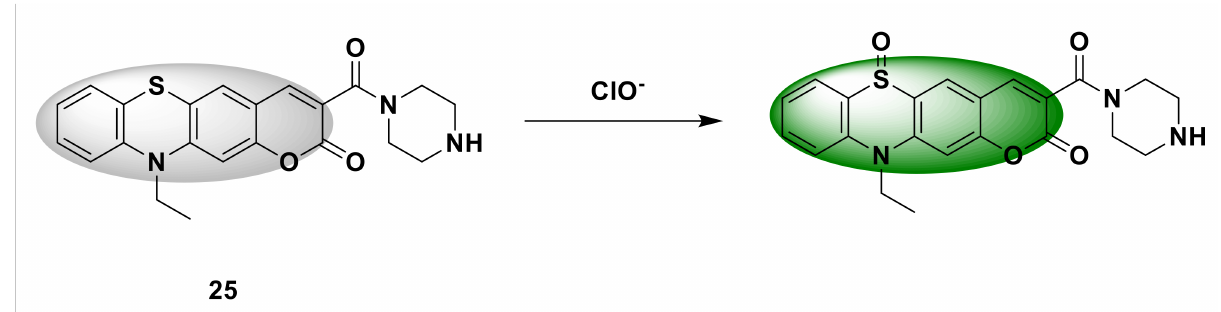
Figure 25. The reaction of probe 25 and ClO −